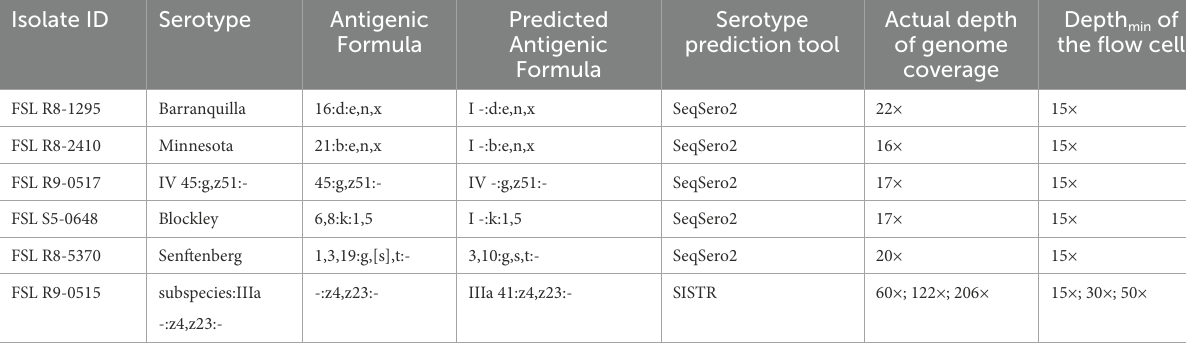
TABLE 4 Salmonella serotype prediction errors. Isolate